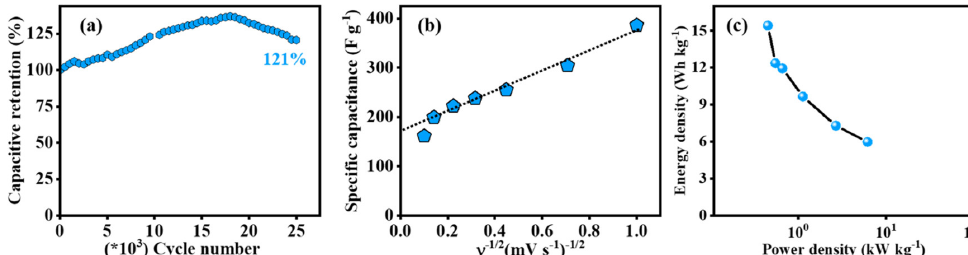
Figure 16. Supercapacitor performance of HRFG-96 in 2 M H 2 SO 4 : ( a ) long-term cyclic stability test for 25,000 cycles at 100 mV s − 1 , ( b ) specific capacitance vs. inverse of the square root of the scan rate, and ( c ) Ragone plot in two-electrode configuration. Reprinted with permission from Ref. [66]. 2022,